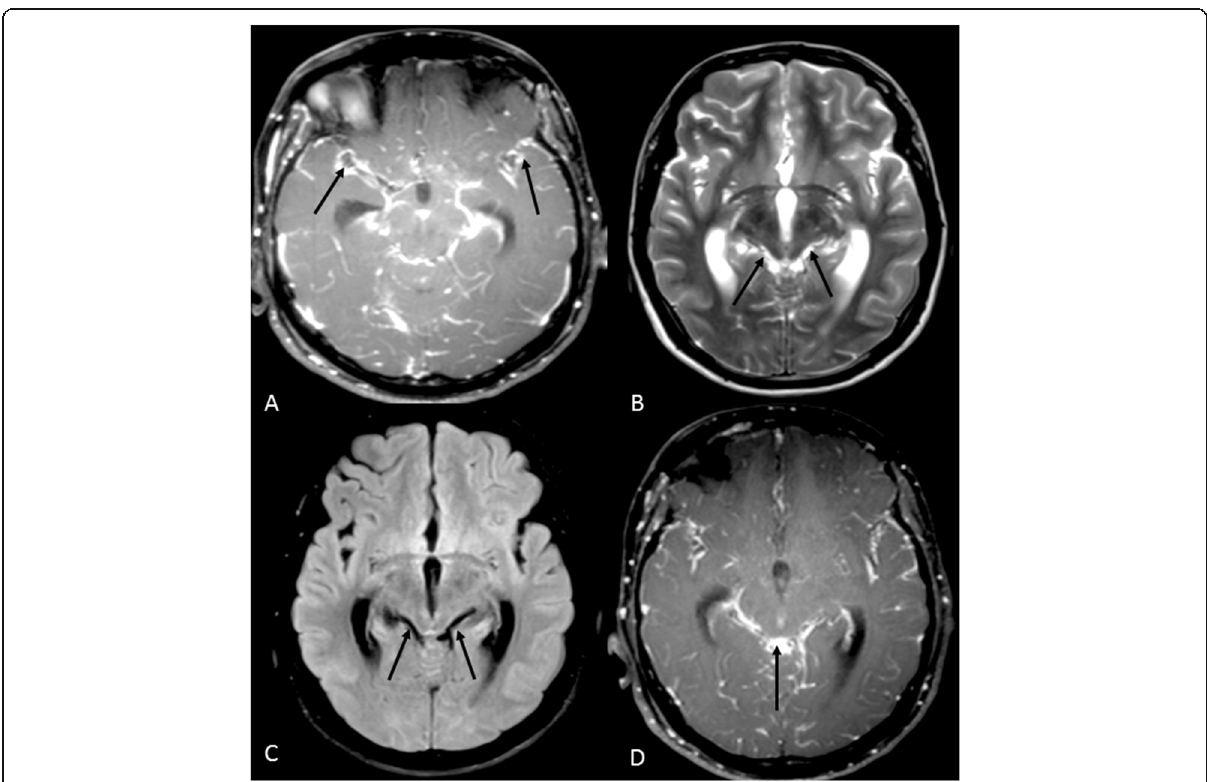
Fig. 2 Magnetic resonance imaging of the brain at 2 months following the onset of symptoms. A Axial T1W post-gadolinium image of the brain at the level of the mid-brain shows nodularity of leptomeningeal enhancement. The black arrows point towards the nodular leptomeningeal enhancement along the Sylvian fissures. B T2W axial image of the brain at the level of the mid-brain shows expansion of the quadrigeminal cistern with inhomogeneous signal of the CSF. The black arrows are seen to point towards the inhomogeneous CSF signal in the quadrigeminal cistern. C Axial FLAIR image of the brain at the level of mid-brain shows complete signal suppression as compared with T2W image in B . The black arrows depict the suppression of CSF signal on FLAIR. D Post- contrast T1W axial images of the brain show enhancement along the CSF spaces corresponding to the T2 and FLAIR images. The black arrows point towards the enhancement along the CSF spaces